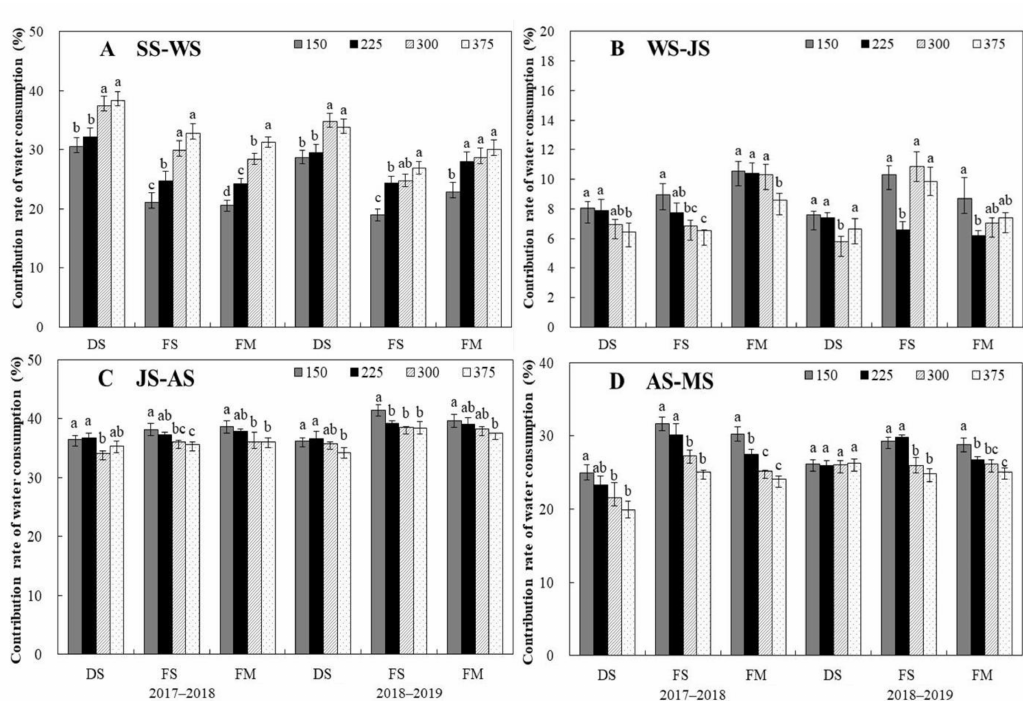
Figure 5. Effect of planting patterns and seeding rate on the contribution rate of soil water con- sumption on grain yield. ( A ) Contribution rate of soil water consumption on grain yield from SS to WS. ( B ) Contribution rate of soil water consumption on grain yield from WS to JS. ( C ) Contribution rate of soil water consumption on grain yield from JS to AS. ( D ) Contribution rate of soil water consumption on grain yield from AS to MS. Different small letters indicate that means within a column are significantly different ( p ≤